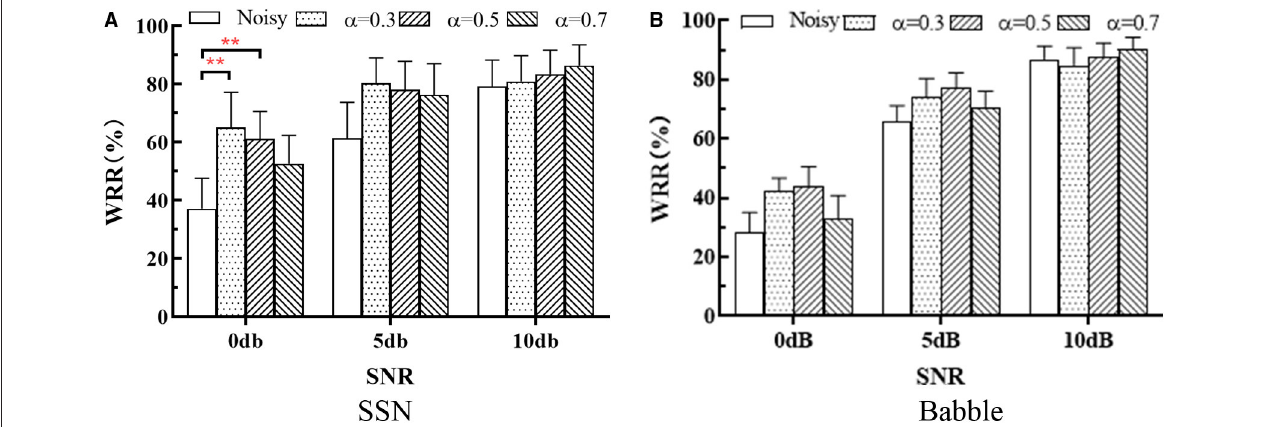
FIGURE 9 | WRR of different systems at different SNRs in (A) SSN and (B) Babble. The bars show the mean WRR of all the subjects, and error bars indicate the standard deviations. The asterisk indicates a significant level, * indicates p < 0.0332, ** indicates p < 0.0021, and *** indicates p < 0.0001. [F (1.616, 5.803) = 80.38, p < 0.001]. Tukey’s multiple